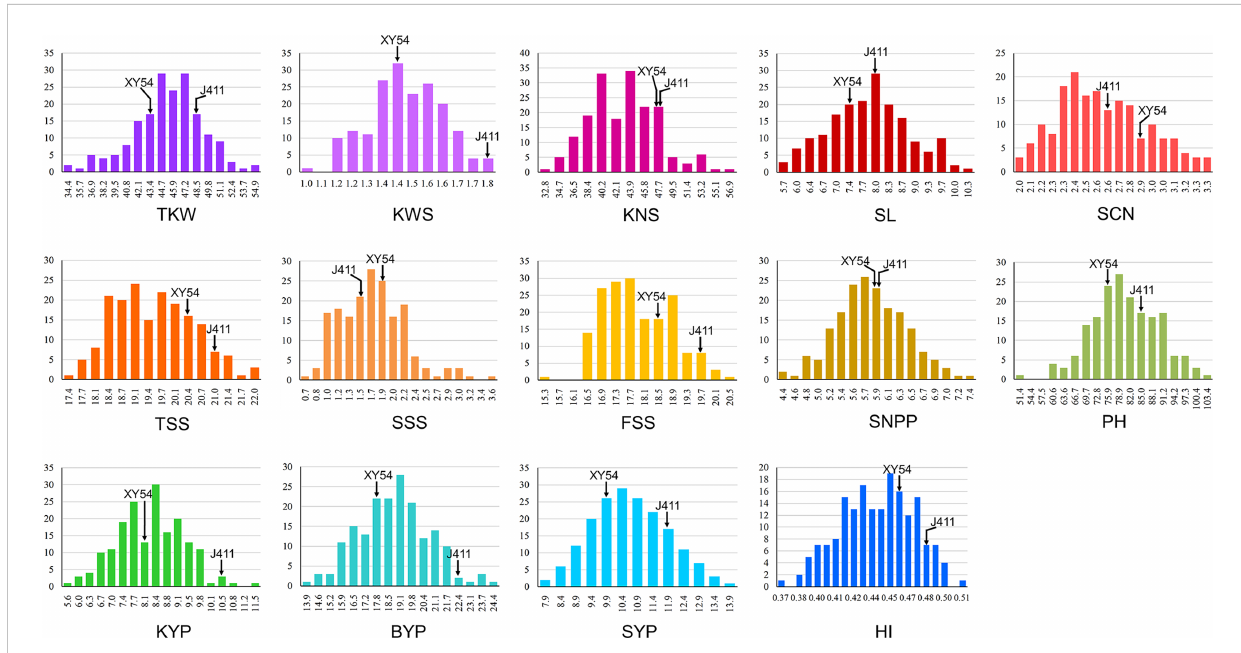
FIGURE 1 Histograms of the Xiaoyan 54/Jing 411 RIL population for thousand kernel weight (TKW), kernel weight per spike (KWS), kernel number per spike (KNS), spike length (SL), spikelet compactness (SCN), total spikelet number per spike (TSS), sterile spikelet number per spike (SSS), fertile spikelet number per spike (FSS), spike number per plant (SNPP), plant height (PH), kernel yield per plant (KYP), biomass yield per plant (BYP), straw yield per plant (SYP) and harvest index